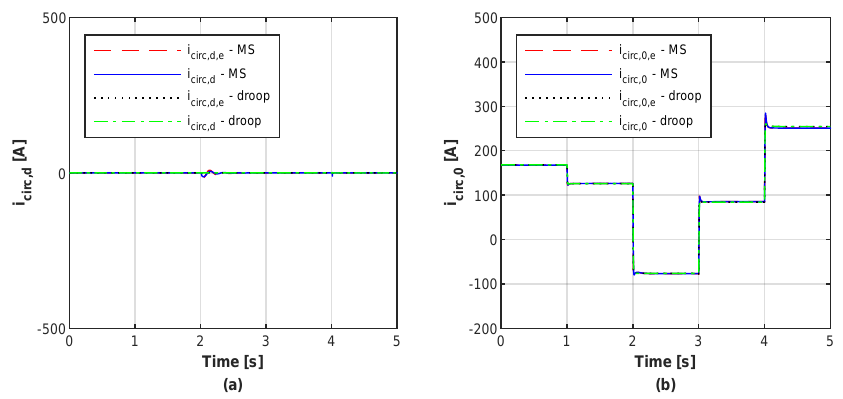
Figure 11. Circulating current response from terminal 2: ( a ) i circ , d ; ( b ) i circ ,0 .